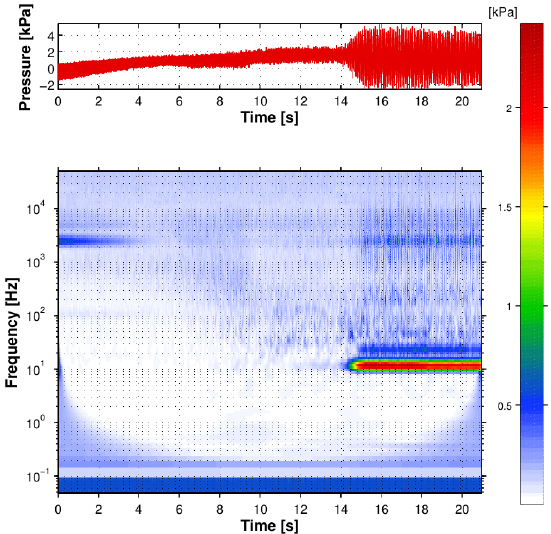
Figure 9: Pressure signal at gauge p imp 2 and its CWT scalogram.